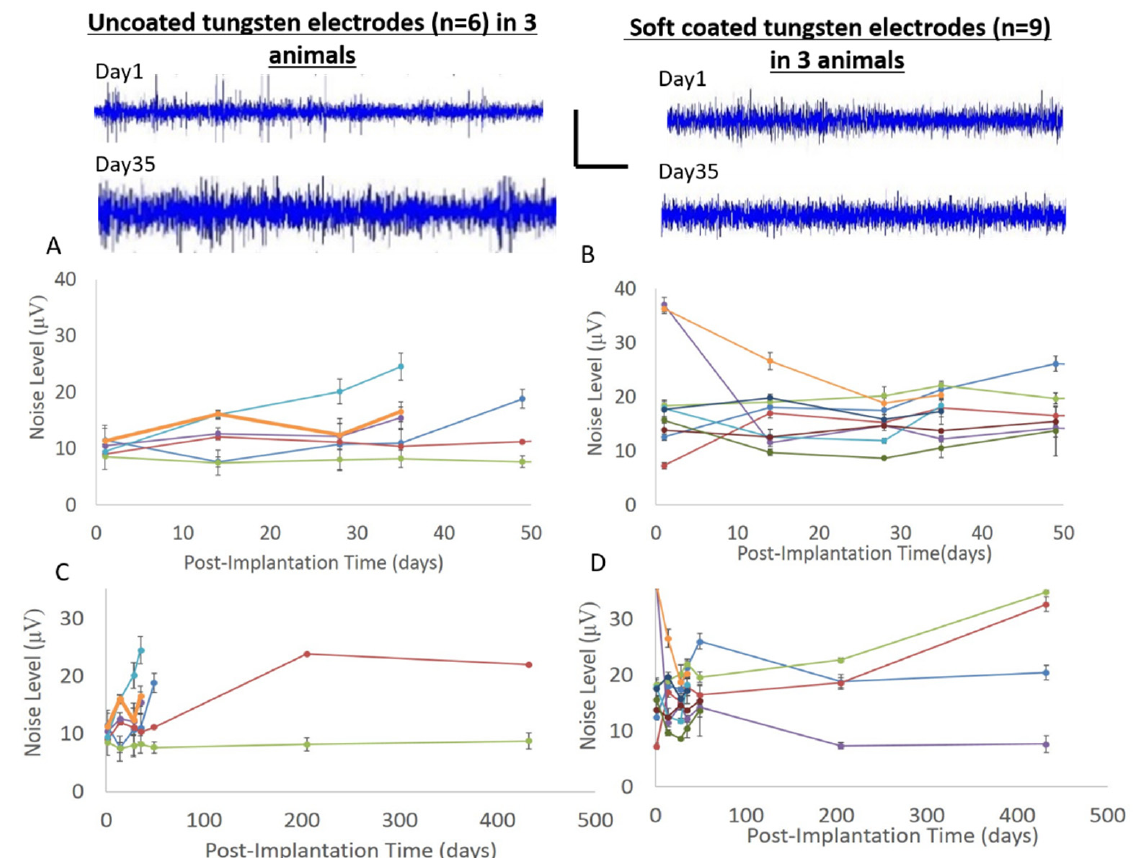
Figure 12. Noise levels are compared for uncoated tungsten in ( A,C ) and for soft-coated tungsten in ( B , D ). Raw traces from select channels at 1 day post implantation and 35 days (5 weeks) post implantation for uncoated (left) and coated probes (right) show modest increase in noise levels for uncoated probes, while soft-coated probes typically did not change. Vertical bar is 50 µV. Horizontal bar is 0.1 s. ( C , D ) show that long-term trends for uncoated and coated probes, respectively remain between 10 and 30 µV.